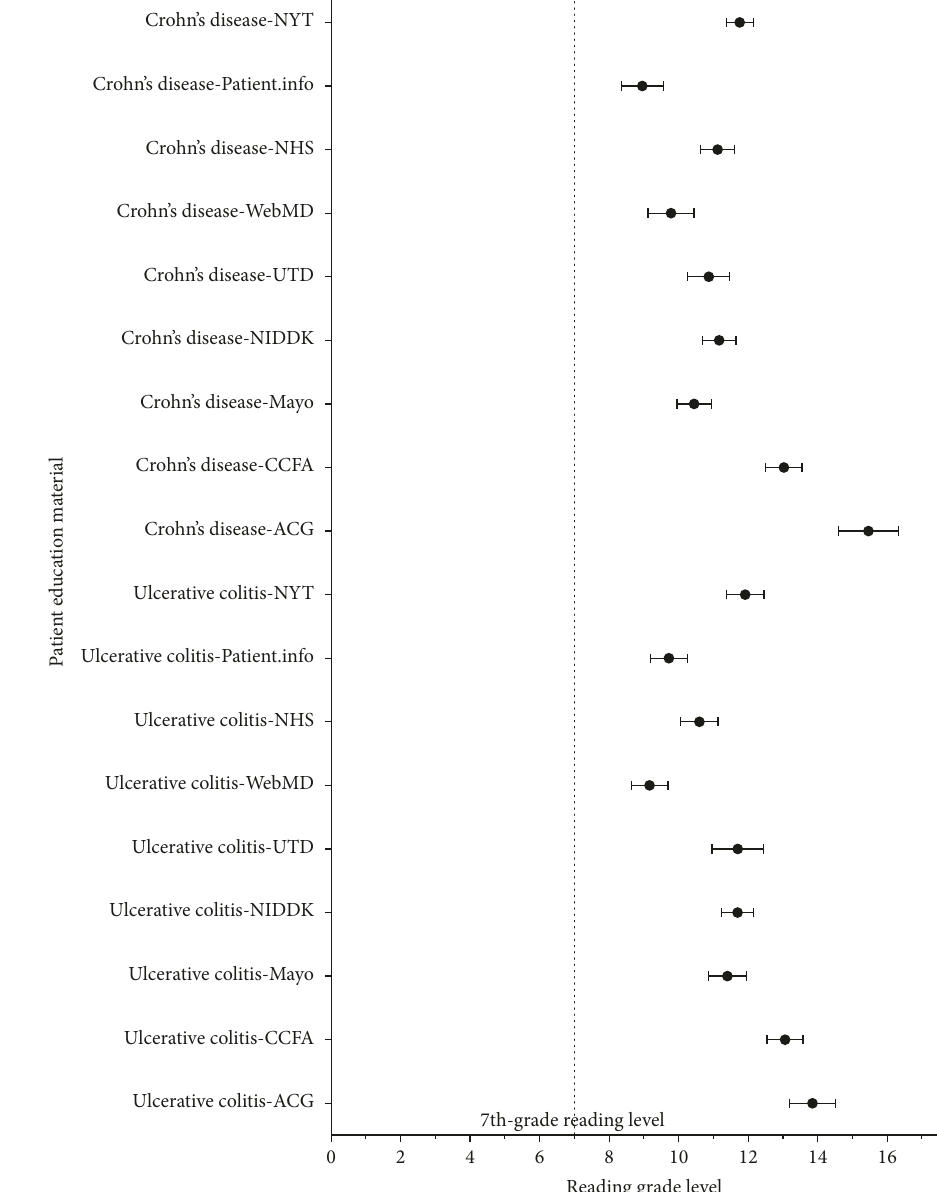
Figure 1: Forest plot showing the mean reading grade level with 95% confidence intervals for Crohn’s disease and ulcerative colitis. The NIH recommend that the reading grade level be under the seventh-grade level. ACG: American College of Gastroenterology; CCFA: Crohn’s and Colitis Foundation of America; Mayo: Mayo Clinic; NIDDK: National Institute of Diabetes and Digestive and Kidney Diseases; UTD: UpToDate, Beyond the Basics; NHS: National Health Service; NYT: New York Times Health